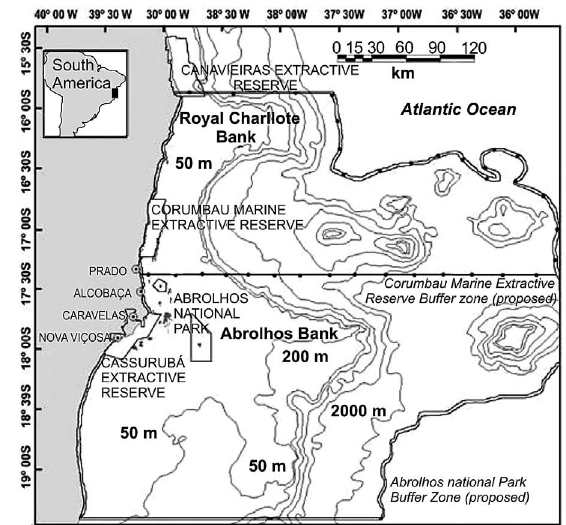
Fig . 1. – Map of the study region showing the Royal Charlotte Bank and the Abrolhos Bank, as well as the marine protected areas and shallow (<30 m) coral